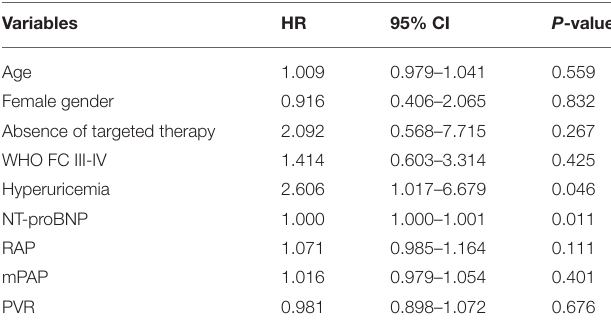
TABLE 3 | Multivariate cox proportional hazards analysis of variables associated with 5-year mortality in patients with idiopathic pulmonary artery